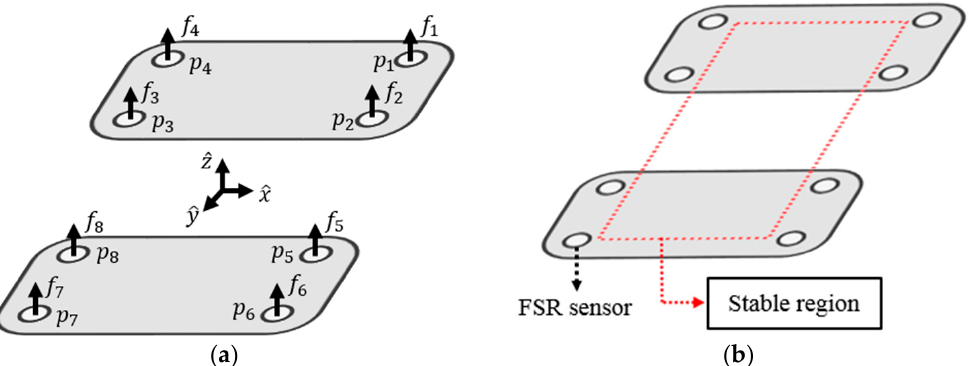
Figure 6. ( a ) Robot’s feet with force-sensing resistor (FSR) sensors; ( b ) Stable region of the zero-moment point (ZMP).